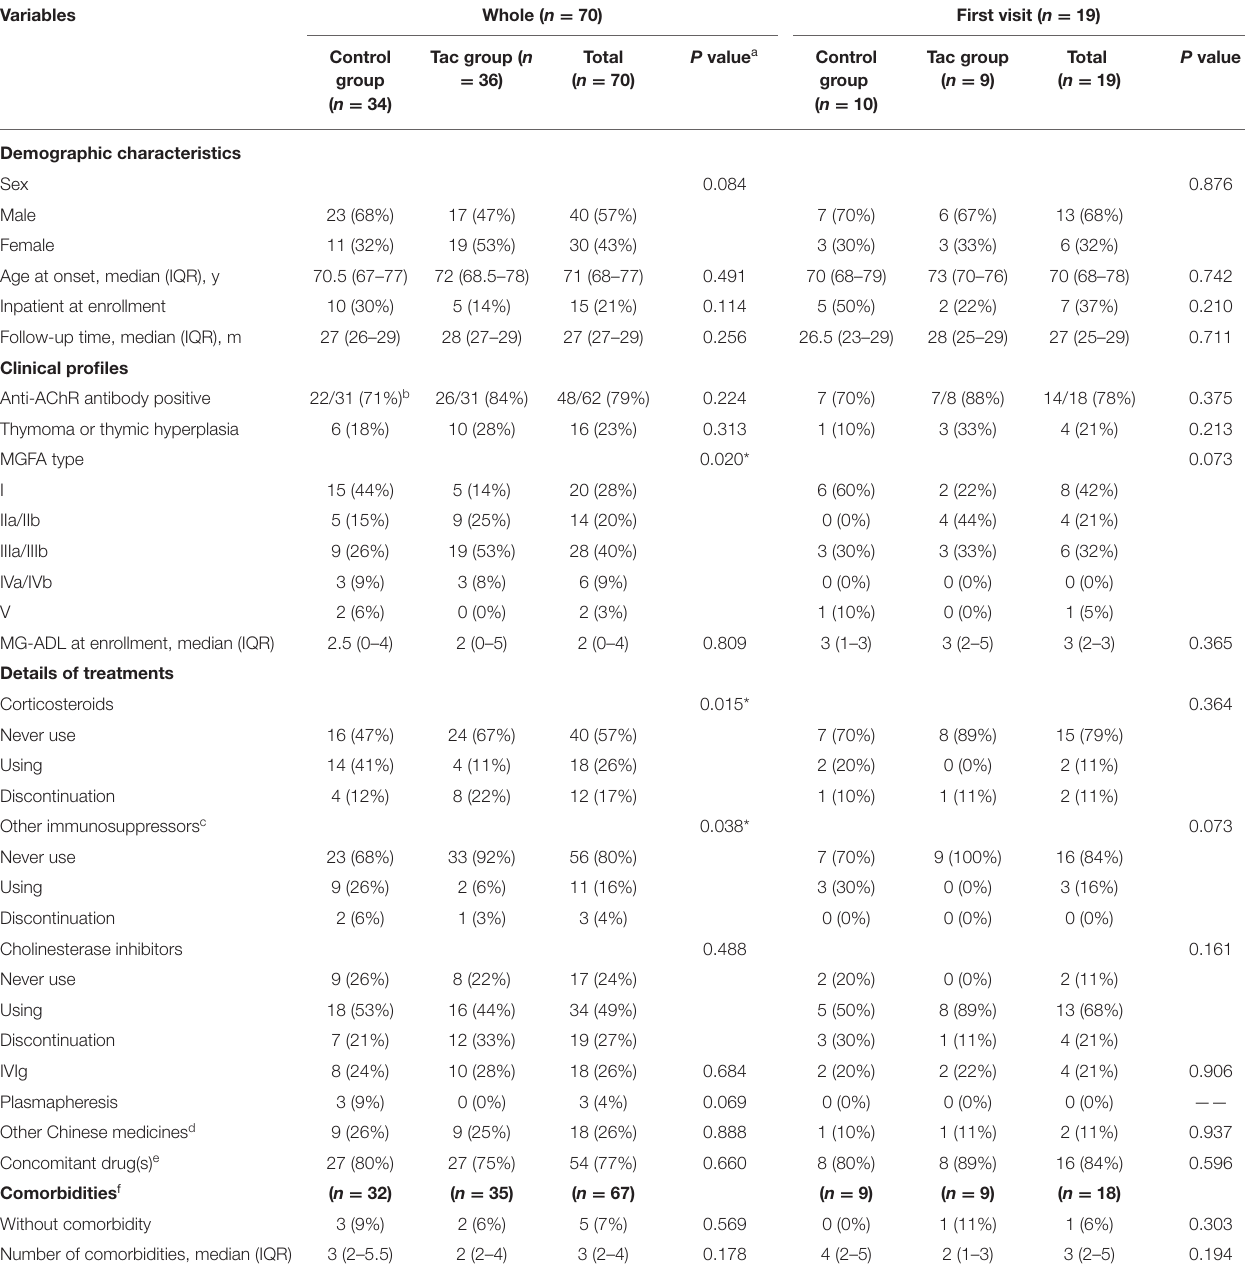
TABLE 1 | Demographical and clinical characteristics of VLOMG patients in the whole cohort and first visit subgroup.